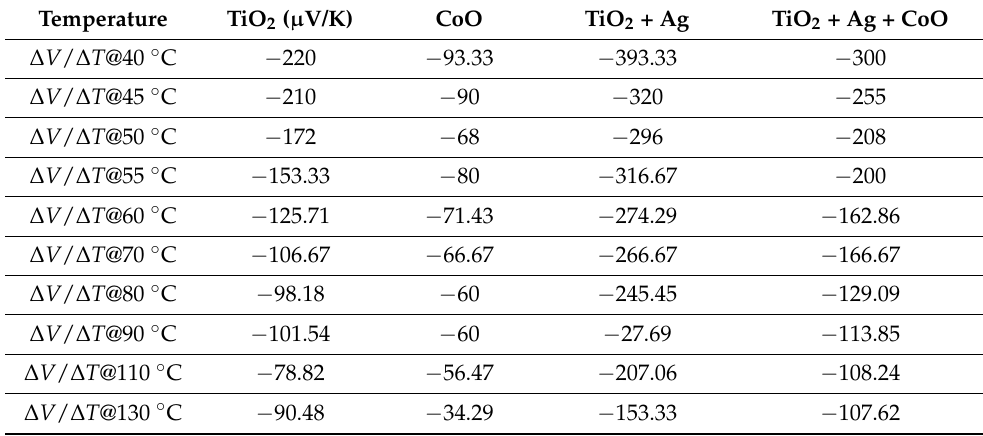
Figure 6. TEM images showing ( a ) TiO 2 nanotubes, ( b ) the diffraction pattern of the TiO 2 nanotubes, ( c ) TiO 2 -CoO nanocables, and ( d ) diffraction pattern of the TiO 2 -CoO nanocables. Reproduced with permission from [91], © 2010, Elsevier B.V. Table 1. Seebeck coefficients of liquid phase deposited thermoelectric